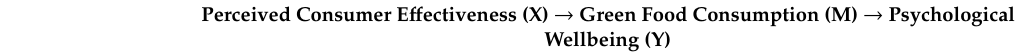
Table 5. Moderating role of social trust ( N =